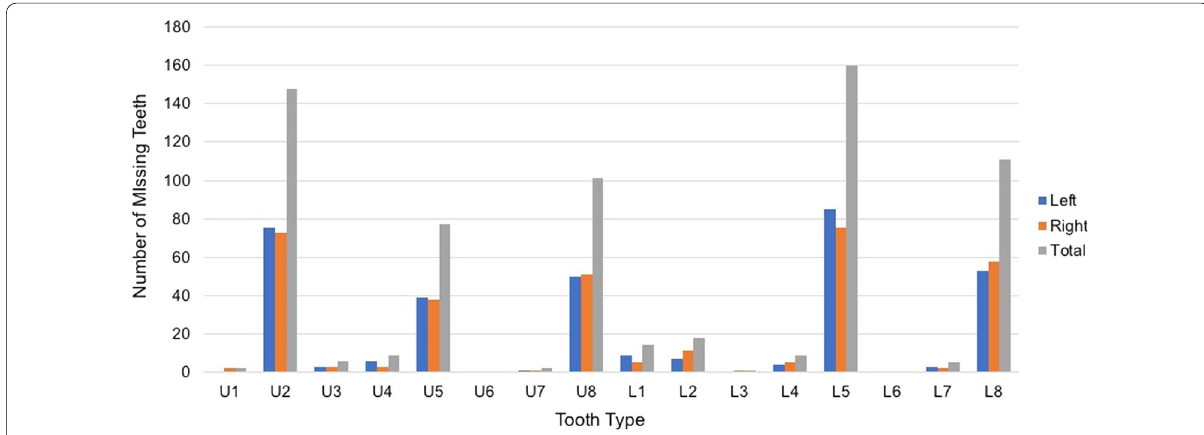
Fig. 2 Distribution of missing teeth in non-syndromic tooth agenesis patients